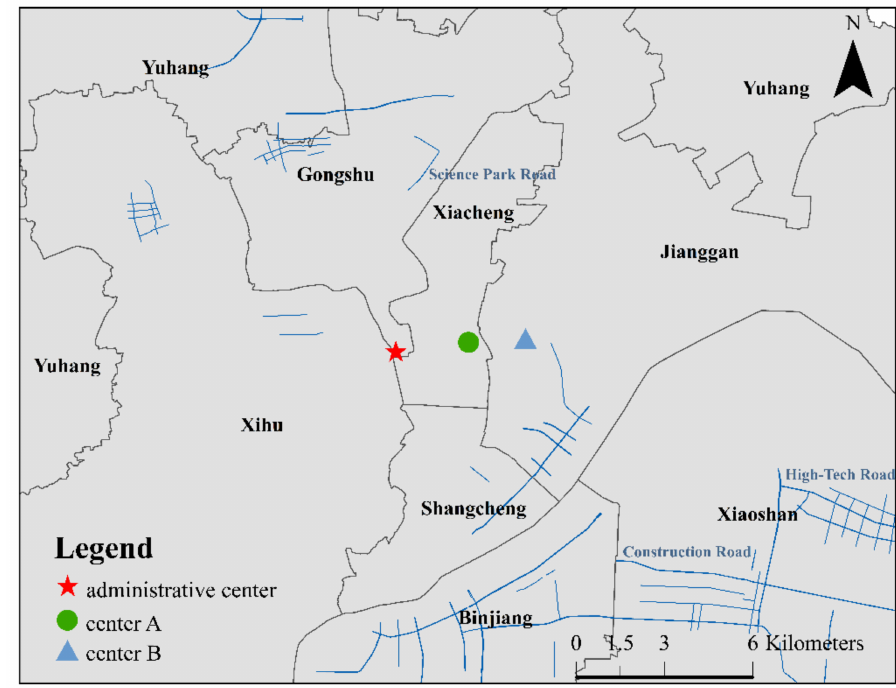
Figure 13. Identified centers based on spatial aggregation results of main street